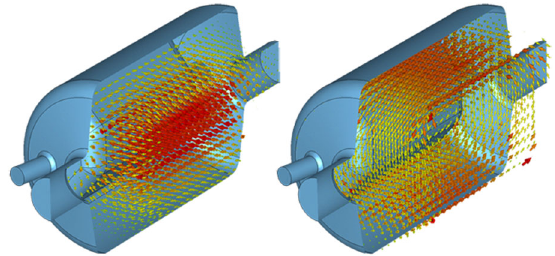
FIG. 2. Electric (left) and magnetic (right) field profile in the rf-dipole cavity.